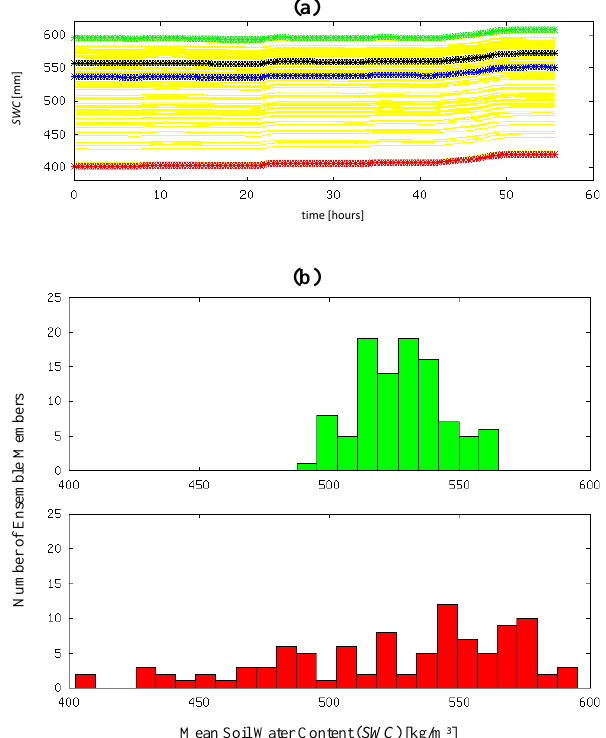
Fig. 7. TERRA-ML’s soil column is 2.43m deep. The soil-water content (SWC) of each grid cell depends on its soil depth (i.e. here 2.43m) and its soil moisture (Eq. 9). SWC in the Enz catchment upstream of Pforzheim (260km 2 ): (a) timeseries of SWC of the CONTROL (black *) and of the ensemble members (yellow), their median SWC (blue *), their minimum SWC (red *) and their max- imum SWC (green *) during the assimilation window; (b) distri- bution of initial mean SWC ( t =0) between the ensemble members. CONTROL mean SWC is 557kg/m 2 . The analysis at t =0 was ob- tained assimilating streamflow from the CONTROL model simula- tion from Pforzheim from t =0 to t =56h with a 0.5 hourly